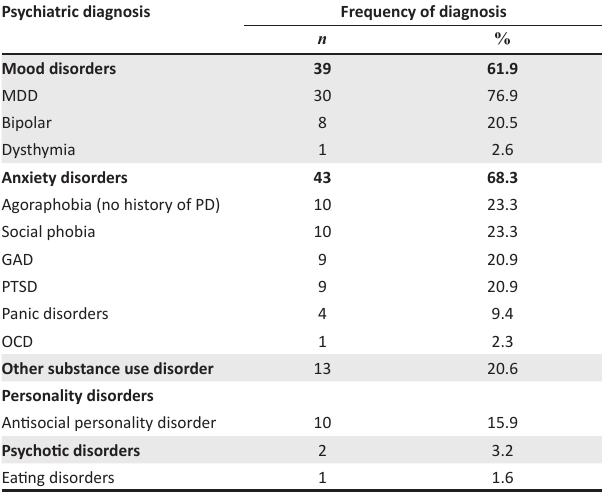
TABLE 3: Frequencies of different psychiatric disorders among patients with comorbidity ( N = 63).